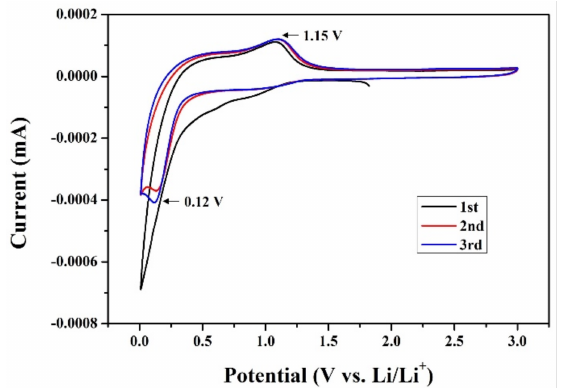
Figure 9. The Cyclic voltammetry (CV) curves of MnO 2 -CNC nanocomposite electrodes.